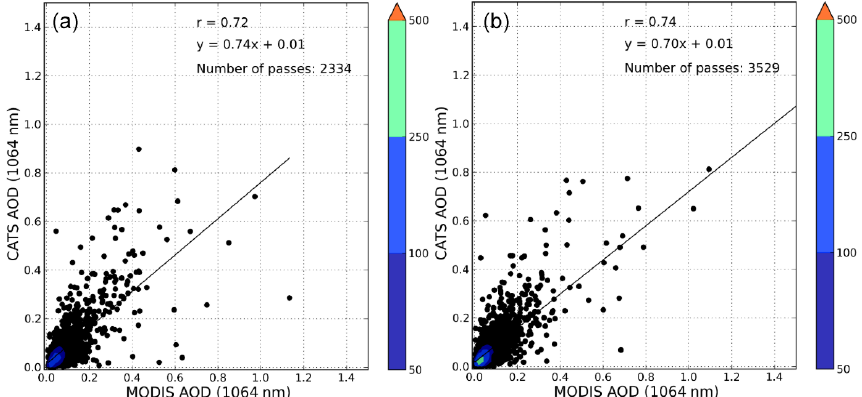
Figure 2. Collocated MODIS C6.1 (a) Terra and (b) Aqua interpolated 1064nm AOD vs. CATS 1064nm AOD with CATS QA